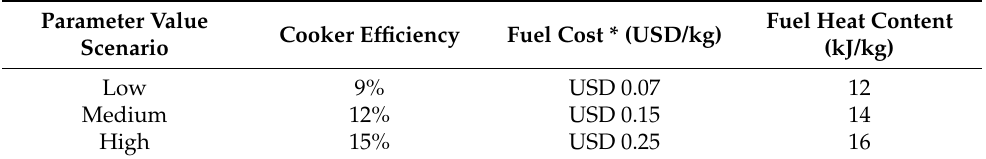
Table 2. WC MLCOE input parameters for calculation of the cost distribution in the WC high-cost case.